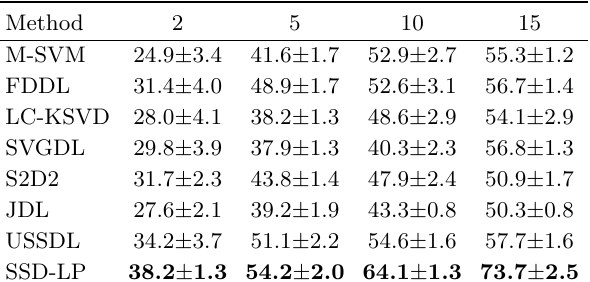
Table 4 Recognition rate for various methods, for different number of labeled training samples, for the Texture-25 database (Unit: %) Method